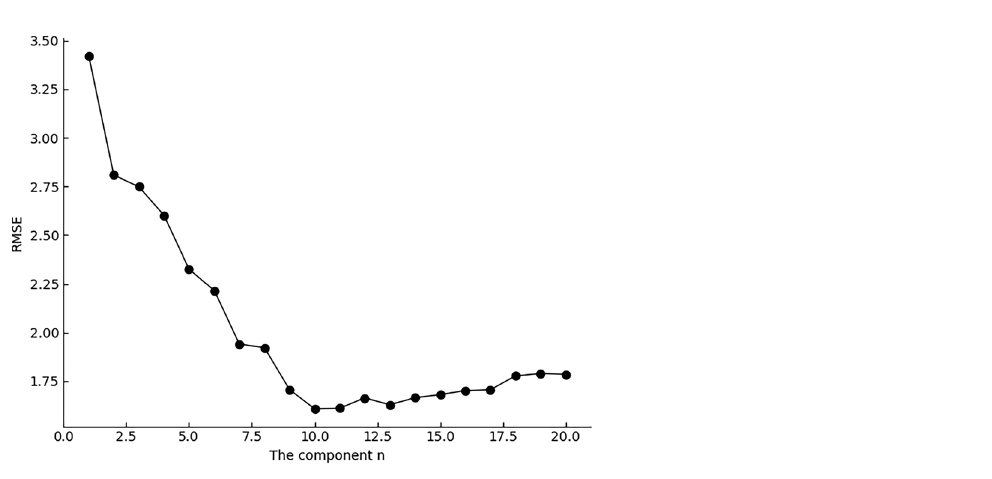
Figure 4. The RMSE with different